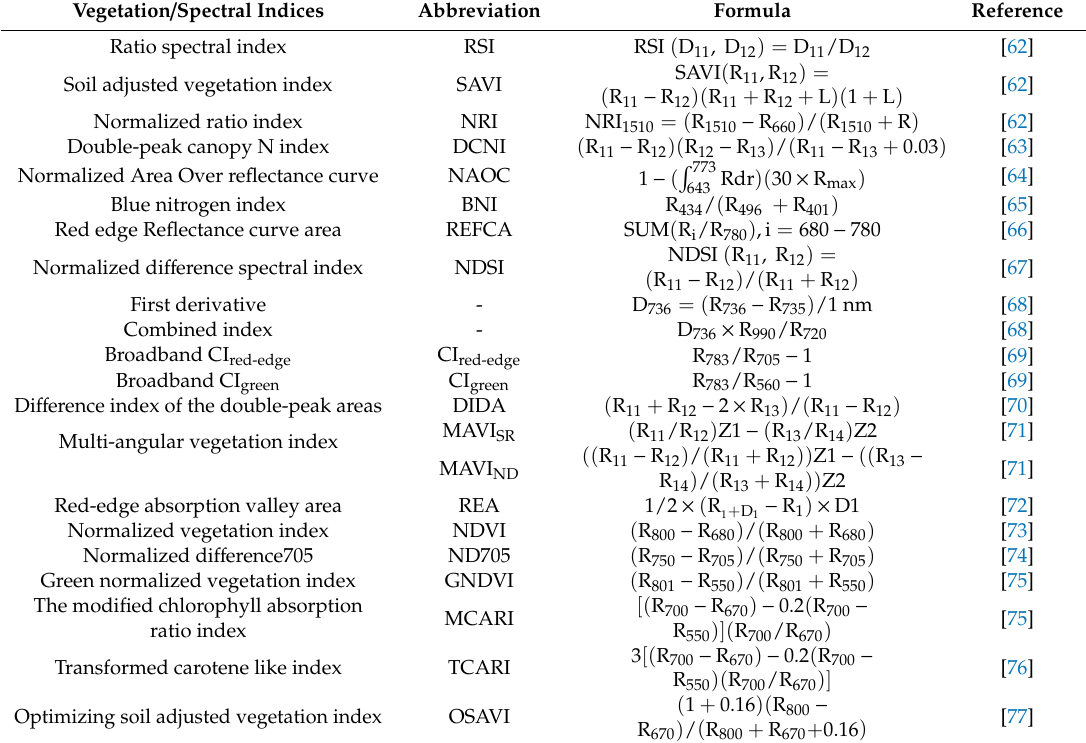
Table 2. Summary of the selected existing vegetation indices (VIs) or spectral indices that are sensitive to the N